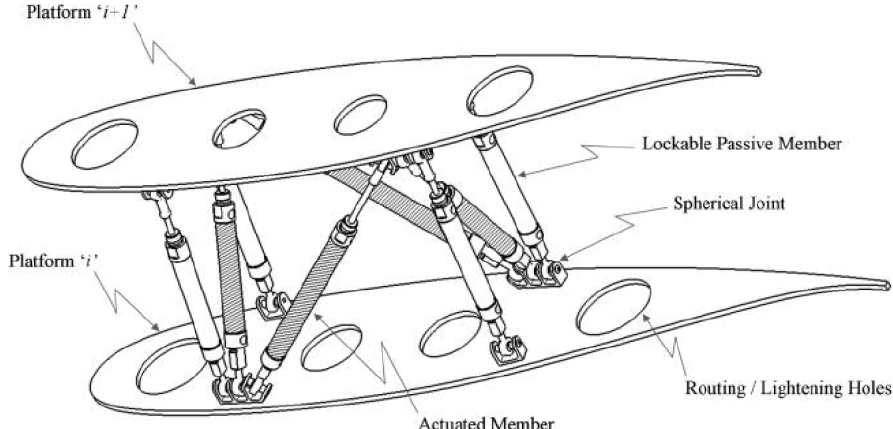
Figure 5. Mechanism of the reconfigurable morphing wing, Topology 1